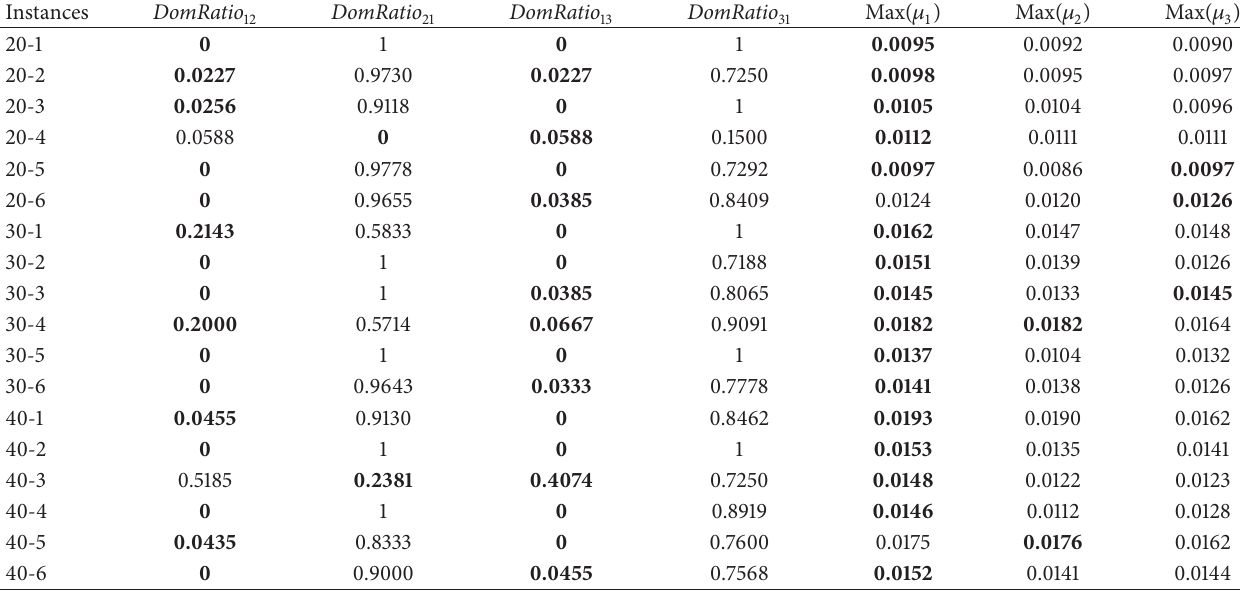
Table 2: Comparison of results obtained by MOABC/D, MOEA/D, and